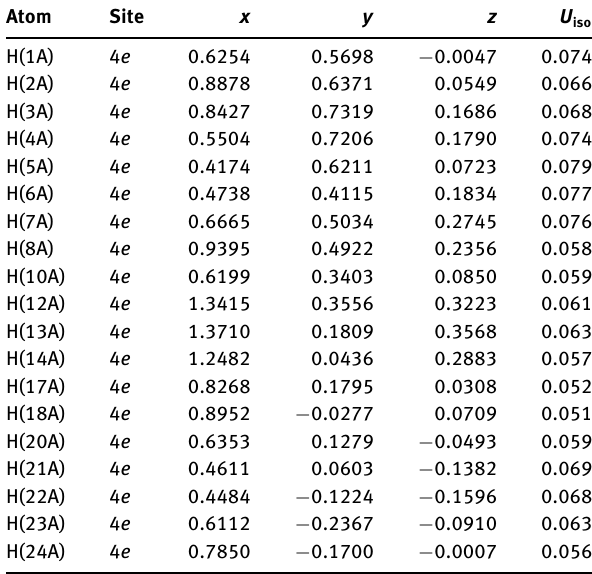
Table 2: Fractional atomic coordinates and isotropic or equivalent isotropic displacement parameters (Å 2